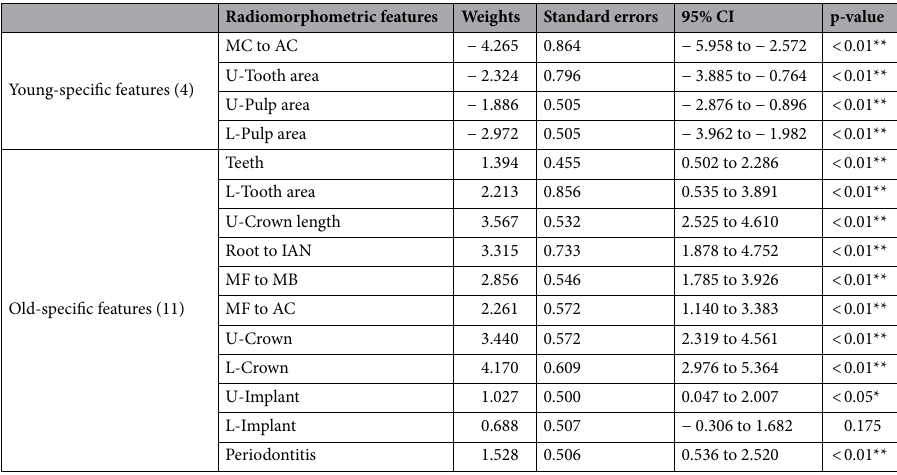
Table 4. Result of linear regression using selected age-specific features. The feature weights and their statistical significance are presented. P-values < 0.05 (*) and < 0.01 (**) are recognized as statistically significant. CI confidence